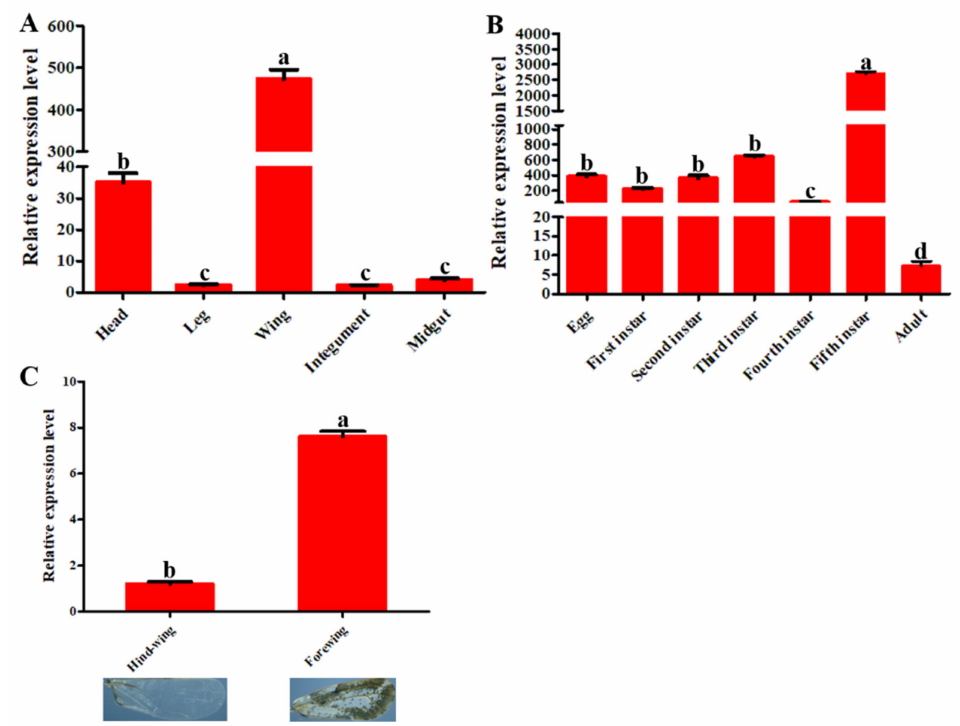
Figure 3. Expression patterns of DcCP64 in different tissues, different developmental stages and fore/hind-wing of D. citri . Relative expression level of DcCP64 was analyzed using RT-qPCR. ( A ) Relative expression levels of DcCP64 in different tissues of D. citri . ( B ) Relative expression levels of DcCP64 in different developmental stages of D. citri . ( C ) Relative expression levels of DcCP64 in fore-wing and hind-wing of D. citri . Datas were normalized using glyceraldehyde-3-phosphate dehydrogenase ( GAPDH ) and are represented as the means ± standard errors of the means from three independent experiments. Relative expression levels were calculated using the 2 − ∆∆ Ct